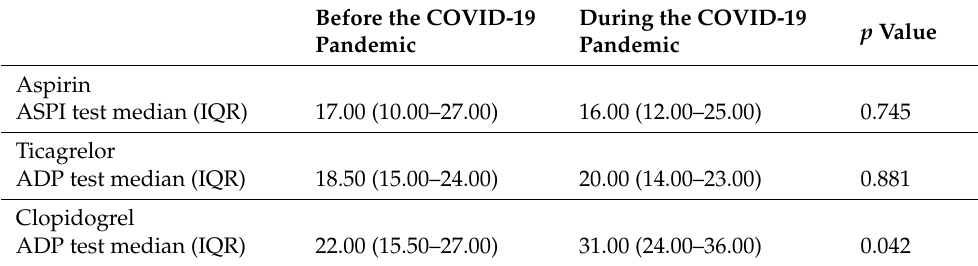
Figure 3. Risk factors for an elevated hemorrhagic risk in patients receiving ticagrelor. Table 4. The influence of the pandemic on the ASPi test and ADP test values. Before the COVID-19